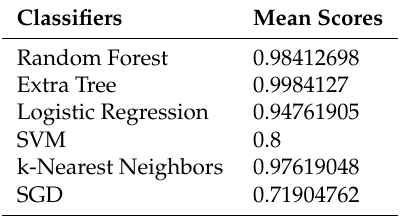
Table 5. Average scores of studied Classifiers.